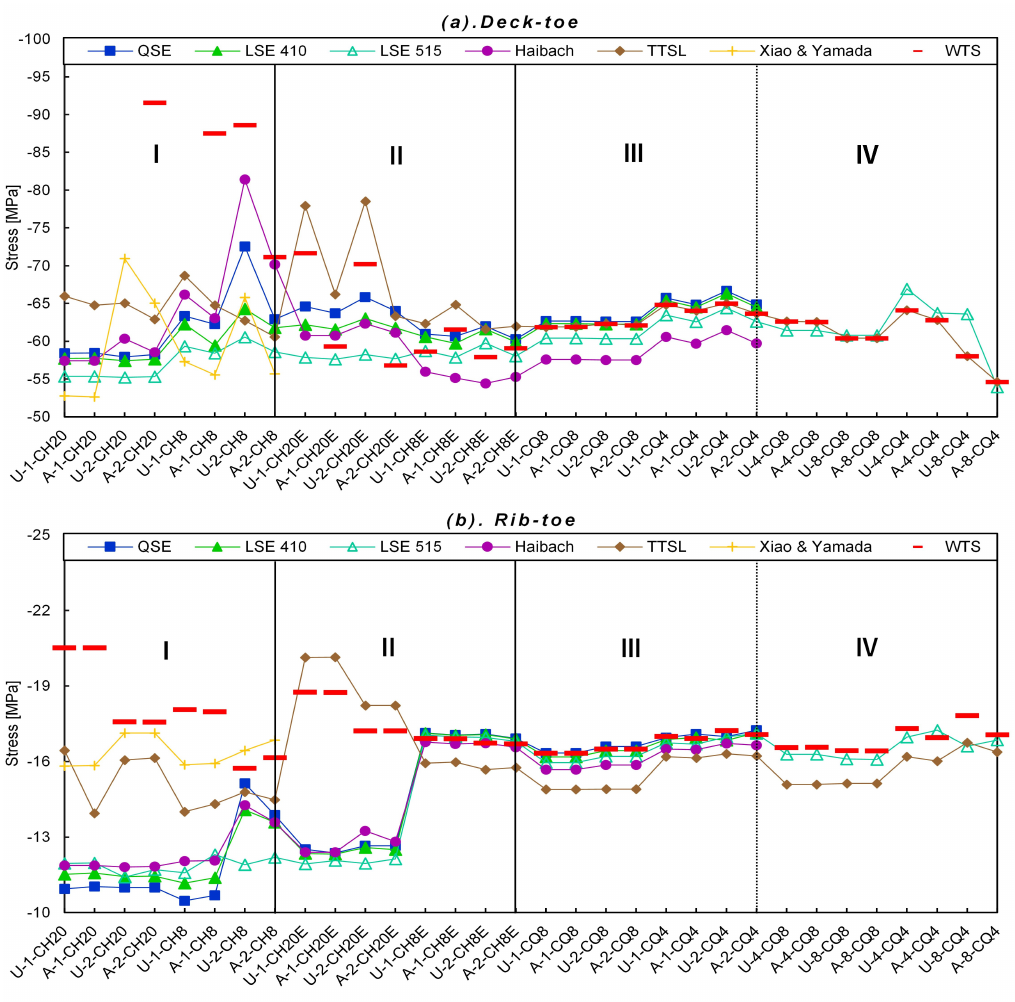
Figure 9. Comparison of SHSS evaluation methods considering di ff erent mesh techniques used in this study. ( a ) SHSS results at the deck-toe. ( b ) SHSS results at the